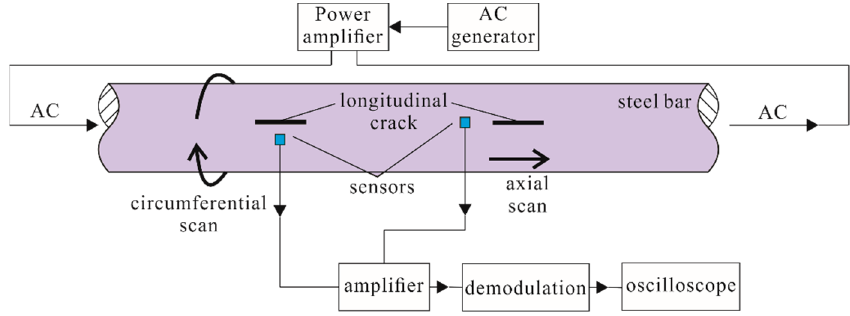
Figure 10. Experimental setup.